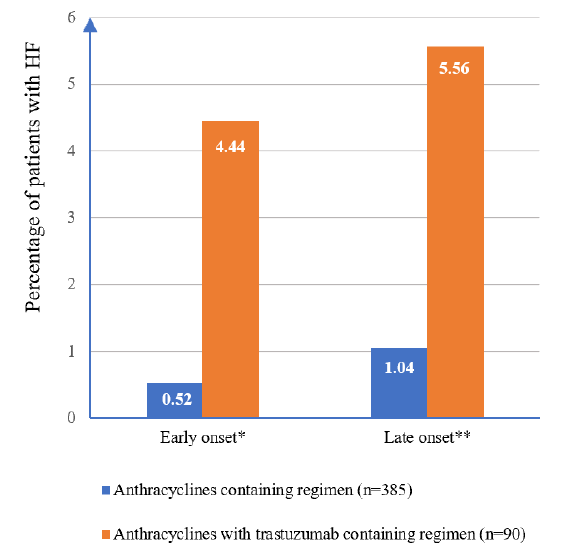
Figure 1. Incidence of HF according to onset ( n = 475). * Early onset refers to HF occurs during the